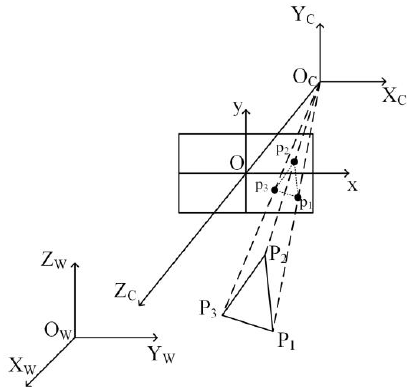
Figure 3. Schematic diagram of the world coordinate system and camera coordinate system